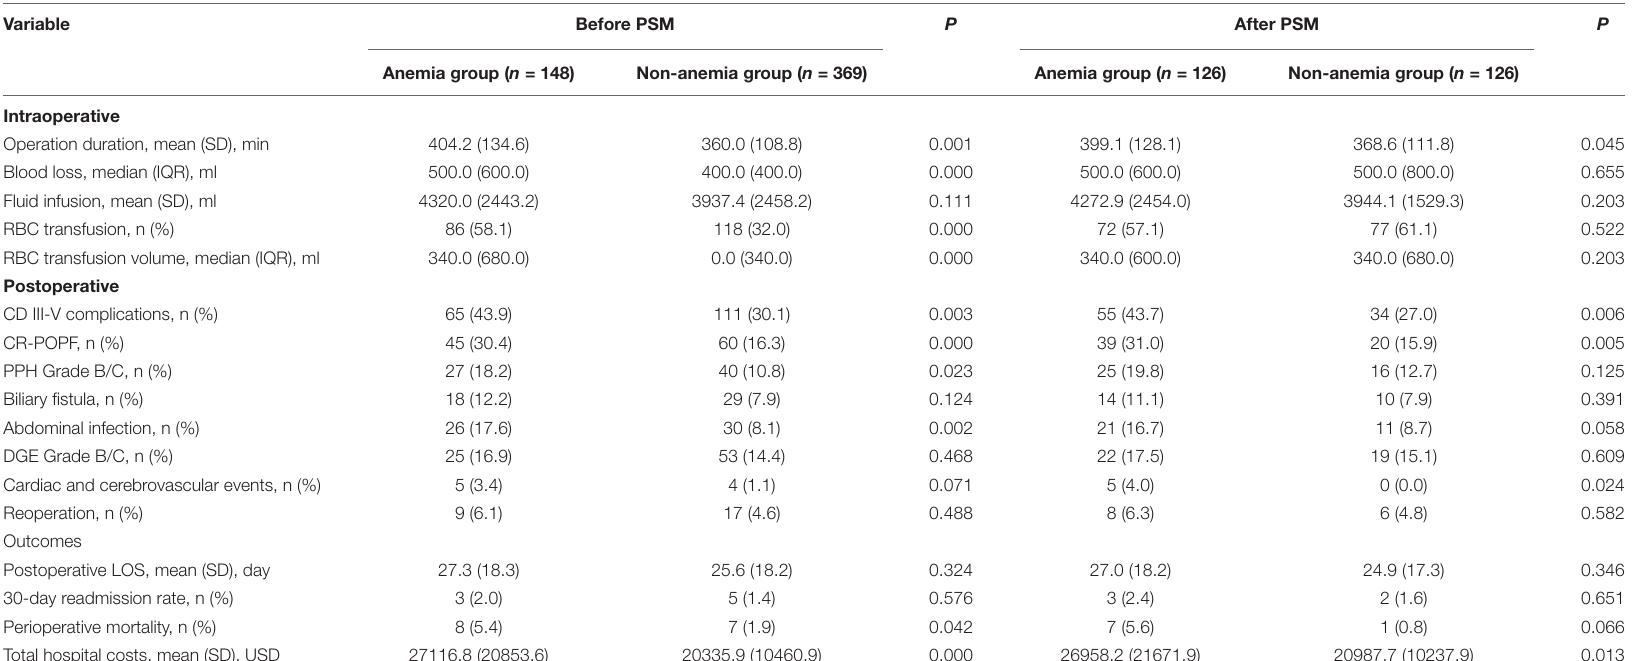
TABLE 2 | Complication and outcome comparison between anemia and no anemia groups. Variable Before PSM P After PSM P Anemia group ( n = 148) Non-anemia group ( n = 369) Anemia group ( n =